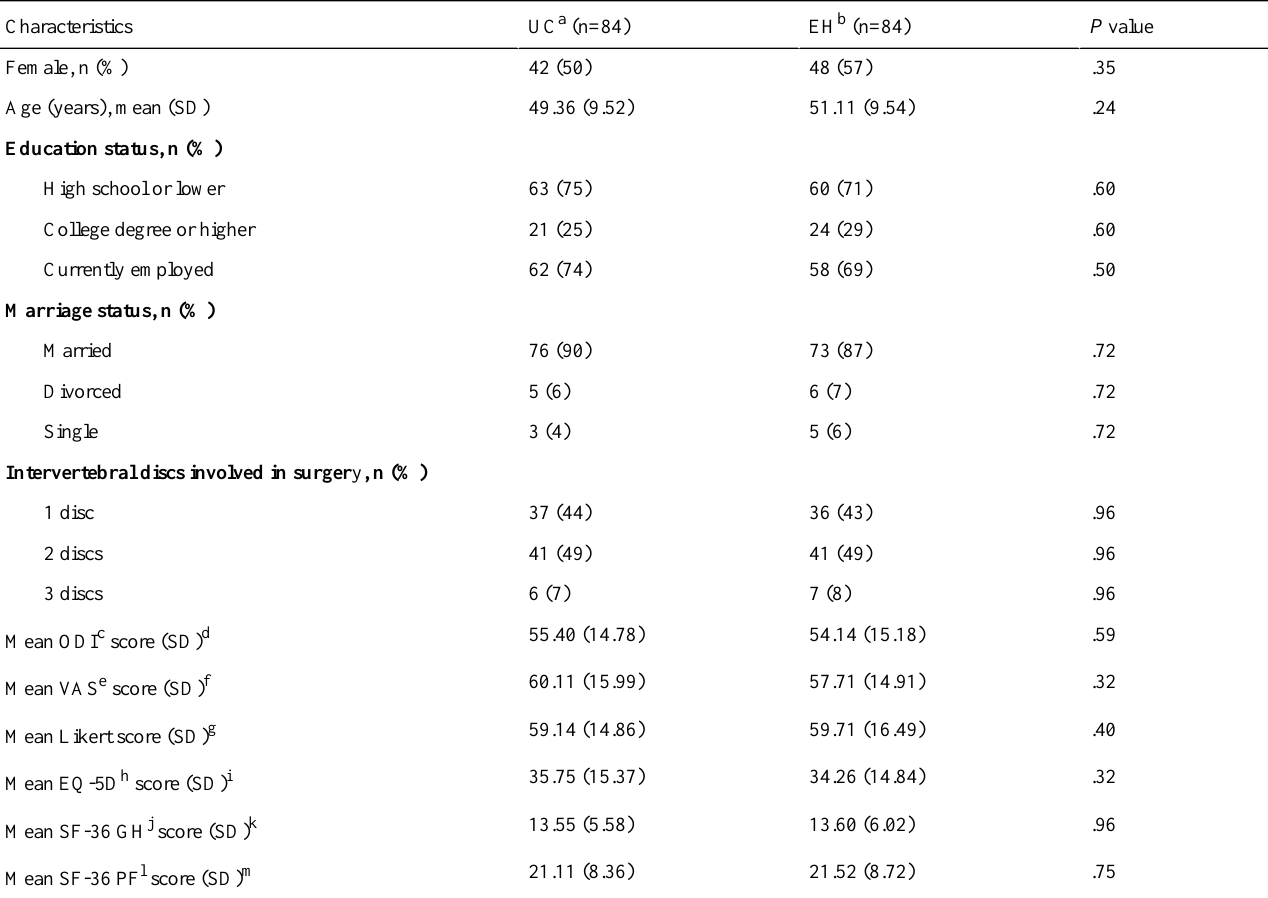
Table 1. Demographics and baseline characteristics of all participants.